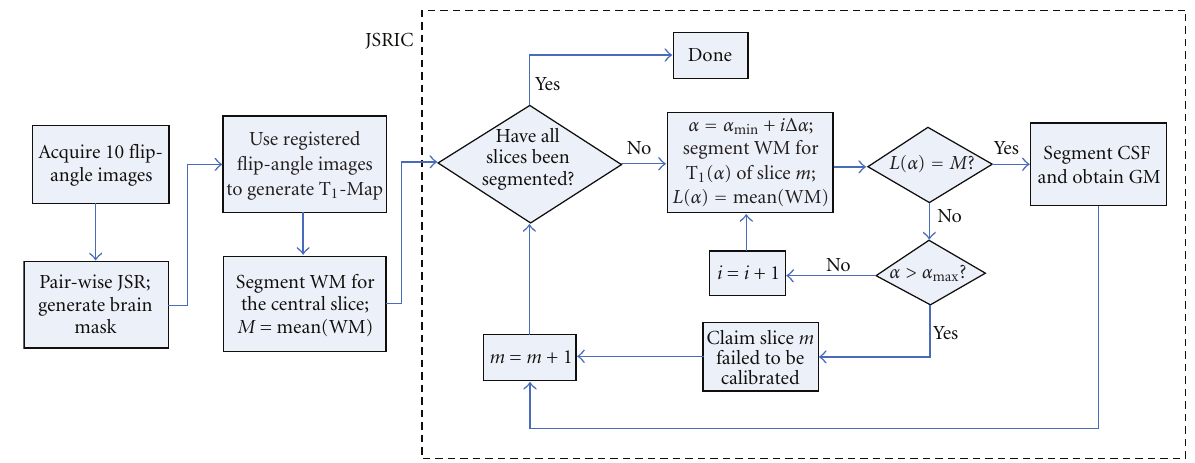
Figure 3: A flowchart for the whole procedure to jointly segment T 1 -Map and calibrate RF-inhomogeneity. The procedure includes the registration of flip angle images, brain mask generation, and our JSRIC method.